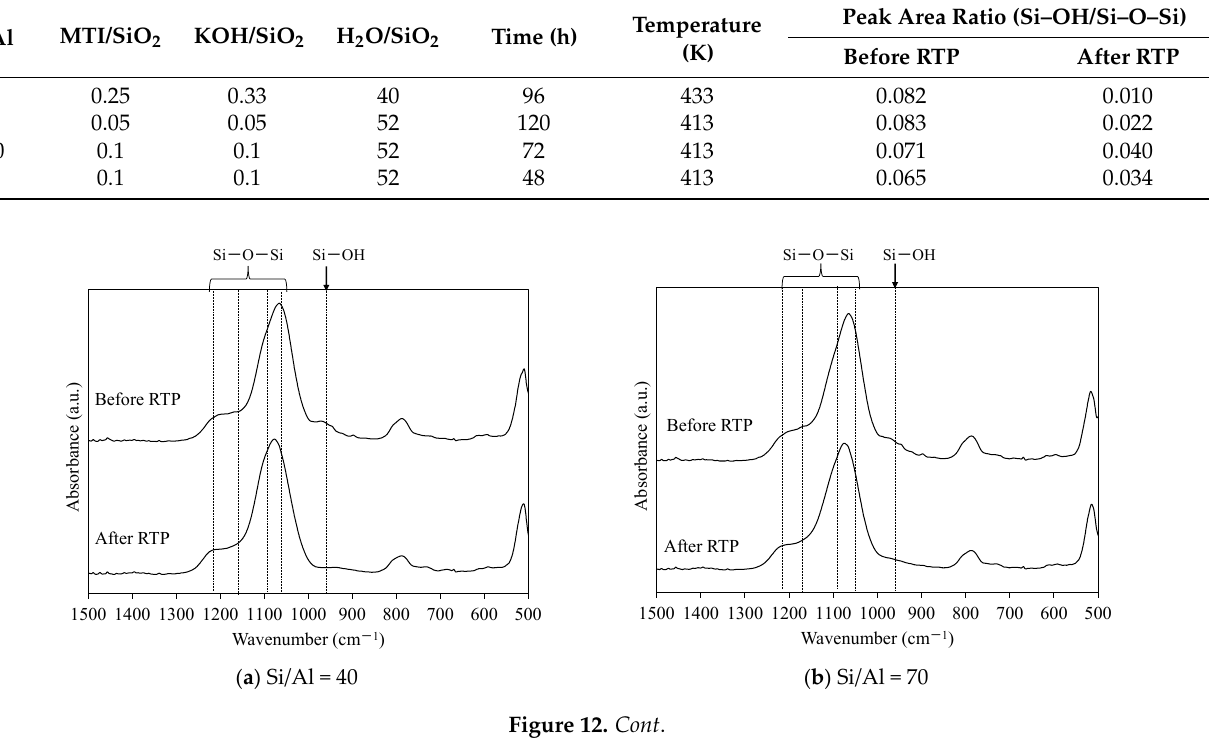
( d ) Si/Al = ∞ Figure 12. FTIR spectra (500 to 1500 cm − 1 ) of the as-made ZSM-58 zeolite crystals with different Si/Al molar ratios ( a – d ) before and after RTP treatment.